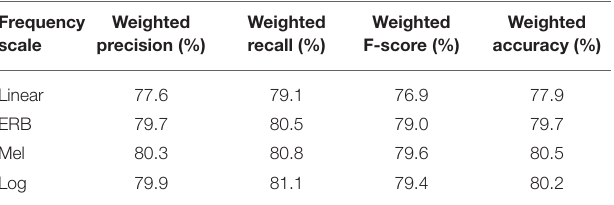
TABLE 3 | Results of Experiment 1—Baseline SER, the sampling frequency of 16kHz (bandwidth = 8kHz), 7 emotions (anger, happiness, sadness, fear, disgust, boredom, and neutral speech), EMO-DB database.